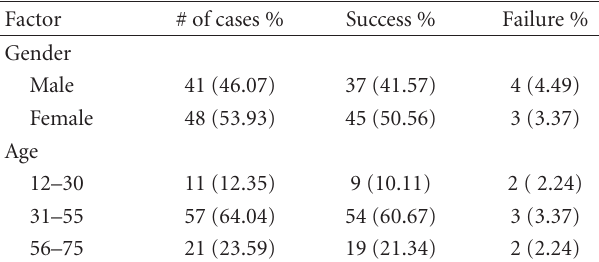
Table 3: Outcome of treatment by gender and age in root canals filled with gutta-percha and ER after 10 years.